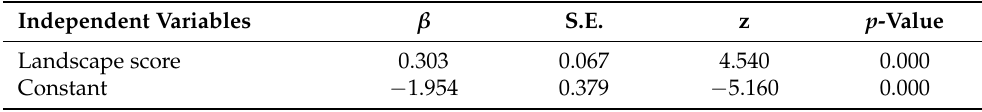
Table 4. Factors influencing the probability that one juice is preferred over the other. Dependent variable: HIGHEST _ LIK (dummy indicating the most preferred juice for each tasted pair). Independent Variables β S.E. z p -Value Landscape score 0.303 0.067 4.540 0.000 Constant − 1.954 0.379 −